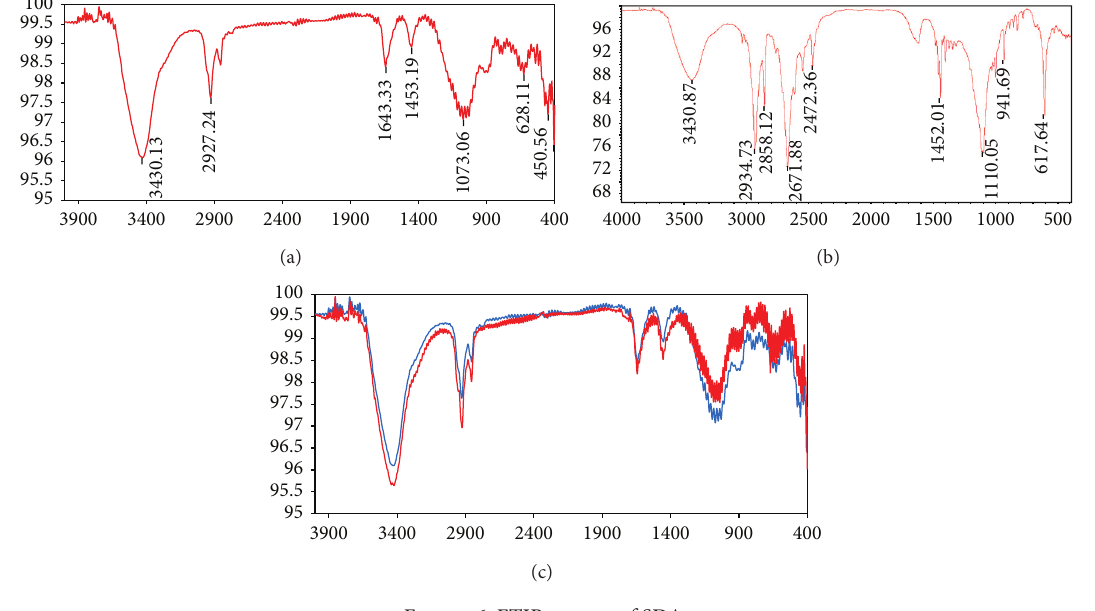
Figure 6: FTIR spectra of SDA. Table 5: The treatment result of five kinds of waste oil-based drilling